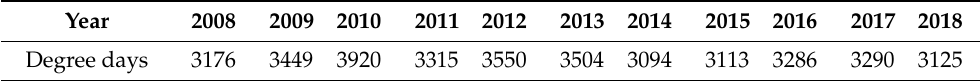
Table 1. Number of heating degree days for Poland (annual data are calculated as sum of monthly data by